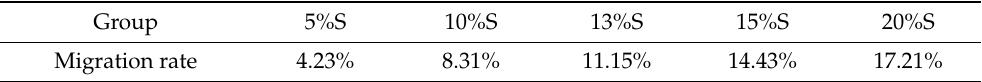
Figure 4. Element mapping images of 28d MASMs with different SRCT composites: ( a ) M5S; ( b ) M10S; ( c ) M13S; ( d ) M15S; ( e ) M20S. Table 3. Migration rate of sulfur of the 28d MASM based on Figure 4. Group 5%S 10%S Migration rate Migration